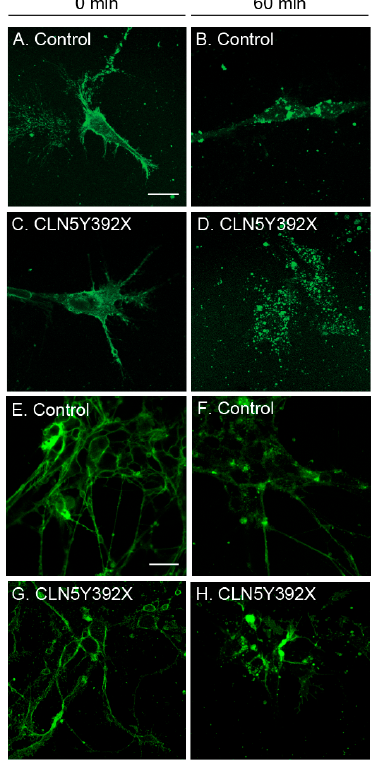
Figure 5. Altered sphingolipid transport in CLN5Y392X iPSC-derived neural lineage cells. Control and CLN5Y392X cells were fed with a fluorescent glycosphingolipid analogue BODIPY-Lactosylceramide (BODIPY-LacCer). Immediately after feeding (0 min chase), BODIPY-LacCer was located at the plasma membrane ( A , C , E , G ); After chasing for 60 min, BODIPY LacCer displayed a typical Golgi distribution in the control cells ( B , F ); whereas the labelling was more dispersed in CLN5Y392X iPSC-derived neural lineage cells ( D , H ). Images shown in the figure are representative of experiments performed on neural lineage cells from two individual control and two CLN5- deficient hiPSC lines in two separate experiments (two different maturation time points, A – D and E – H ). Bar 20 µm.